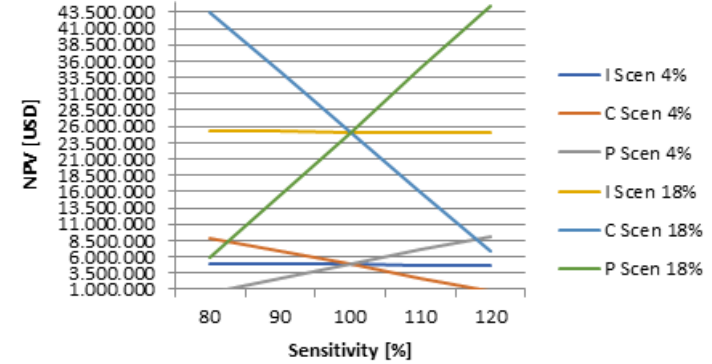
Figure 3: Graph of sensitivity I, C, R to NPV in scenario 4% and